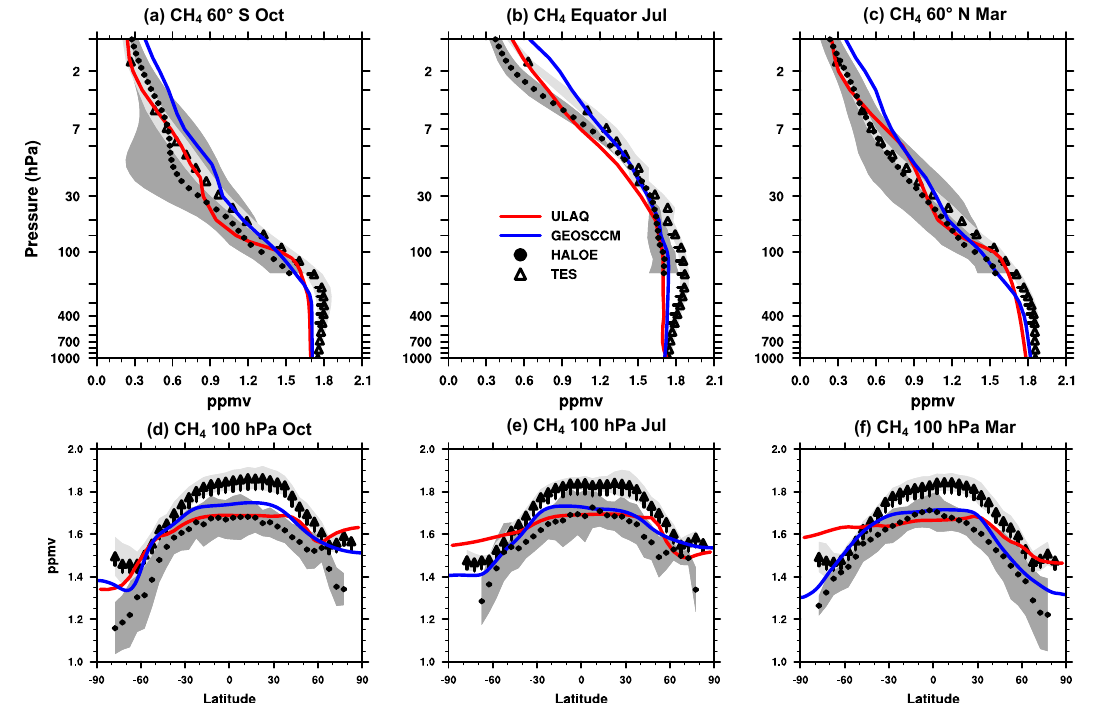
Figure 1. Evaluation of zonal and annual mean CH 4 mixing ratios ULAQ-CCM (red) and GEOSCCM (blue) simulations averaged over 1991–2010. Observations are taken from HALOE (black dots, average 1991–2005) (Grooß and Russell III, 2005) and TES Aura (black triangles, average